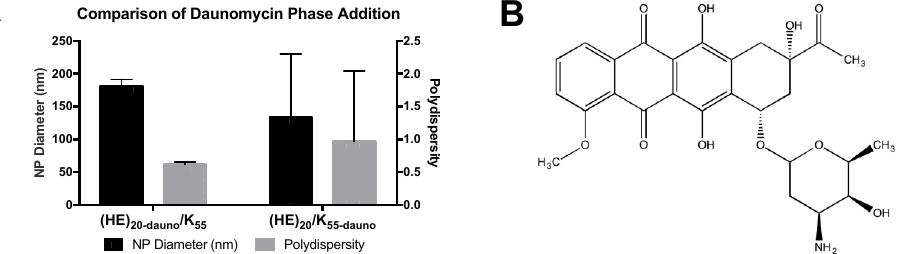
Figure 4. Comparison of daunomycin phase addition. ( A ) In two separate experiments daunomycin was dissolved in the histidine and glutamic acid peptide ((HE) 20 ) solution ((HE) 20-dauno ) prior to PEC formation or in the K 55 solution (K 55-dauno ). The PEC formed from (HE) 20-dauno and K 55 were ~180 ± 10 nm in diameter with a polydispersity index (PDI) of 0.6 ± 0.04. Conversely the PEC formed from (HE) 20 and K 55-dauno were ~130 ± 96 nm in diameter with a PDI of 0.96 ± 1.0. Data shown are averages of 4 wells ± standard deviation; ( B ) Structure of encapsulated daunomycin.